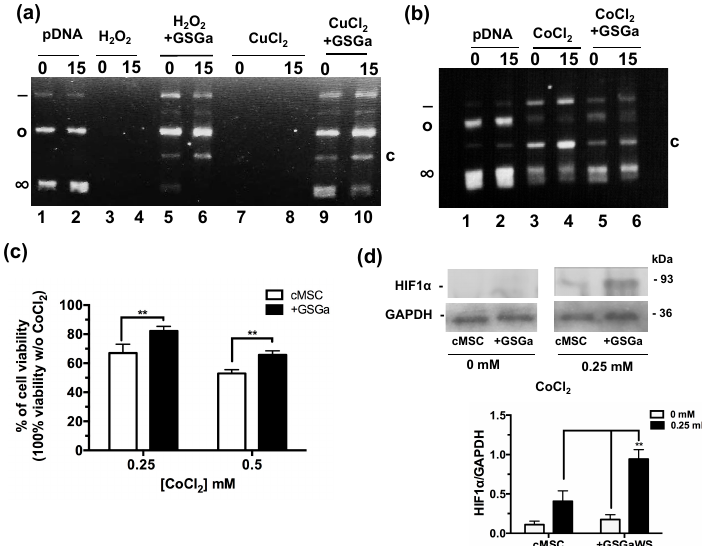
Figure 2. Antioxidant properties of GSGa . ( a ) Inhibition of pDNA cleavage by GSGa; 0.5 μ g of pDNA after addition of H 2 O 2 (100 μ M) or CuCl 2 (100 μ M) and ascorbic acid (10 mM) in 20 mM Tris HCl, pH 7.4, buffer after 0 (lane 1) or 15 min (lane 2) of incubation at 37 °C in the absence (lane 3, 4, 7 and 8) or in the presence (lane 5, 6, 9 and 10) of 10.8 µ g / µ L of GSGa. ( b ) 0.5 µ g of pDNA after addition of CoCl 2 (100 µ M) and ascorbic acid (10 mM) in 20 mM Tris HCl, pH 7.4, bu ff er after 0 (lane 1) and 15 (cid:48) (lane 2)